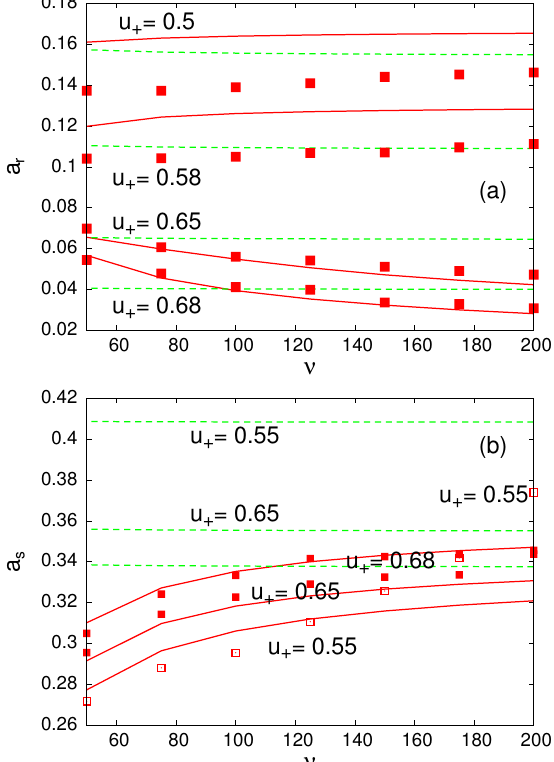
Figure 6. Comparison between theory and numerical solutions of the nematic Equations (11) and (12) with the initial condition (13) for the nematic CDSW. Numerical amplitude: red squares; amplitude (70): red (solid) line; amplitude given by the Kawahara equation (equation (42) with c 1 = c 2 = c 3 = 0): green (dashed) line. ( a ) Resonant wave amplitude a r , ( b ) CDSW solitary wave amplitude a s (67). Note that, for clarity, the numerical DSW amplitude for u + = 0.55 is denoted by red open squares. Here, u − = 1.0 and q =